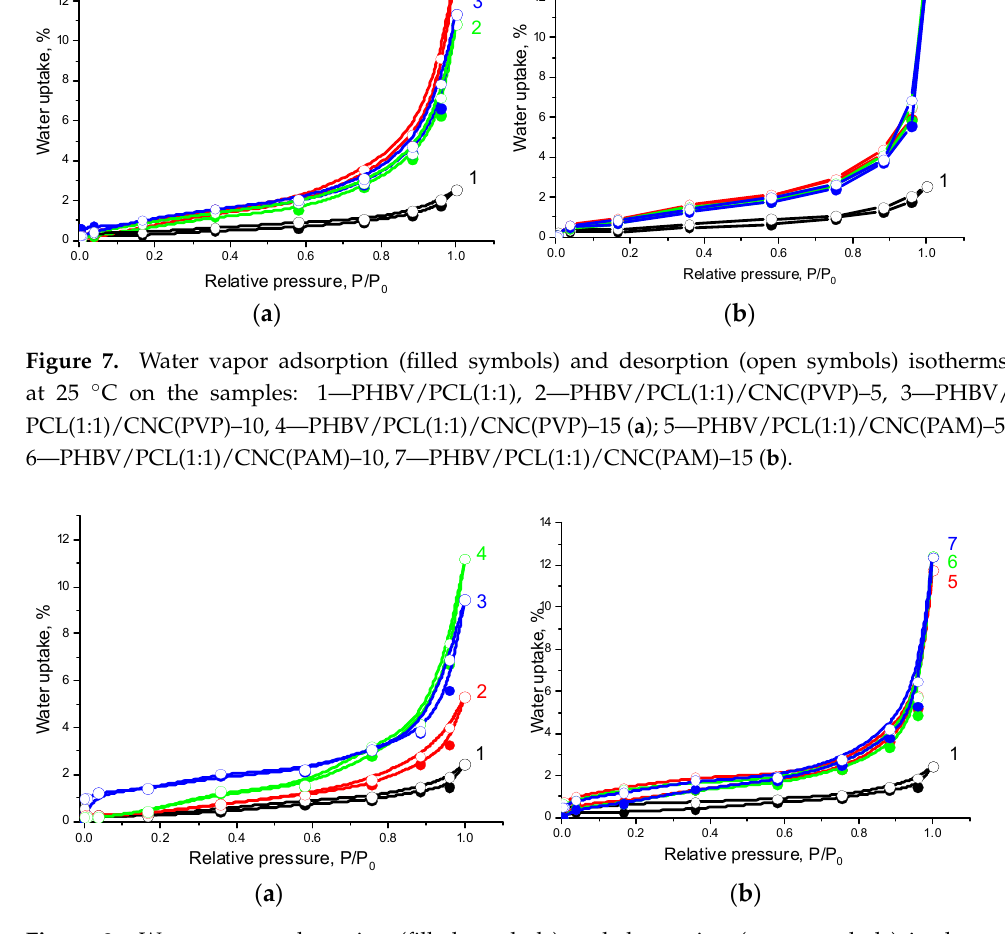
Figure 8. Water vapor adsorption (filled symbols) and desorption (open symbols) isotherms at 25 ◦ C on the samples: 1—PHBV/PCL(1:2), 2—PHBV/PCL(1:2)/CNC(PVP)–5,